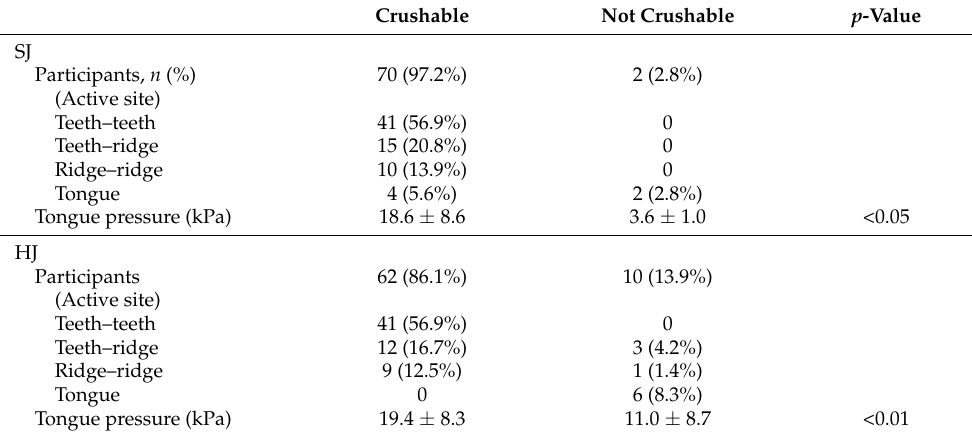
Table 4. Crushability by free crush ( n = 72).